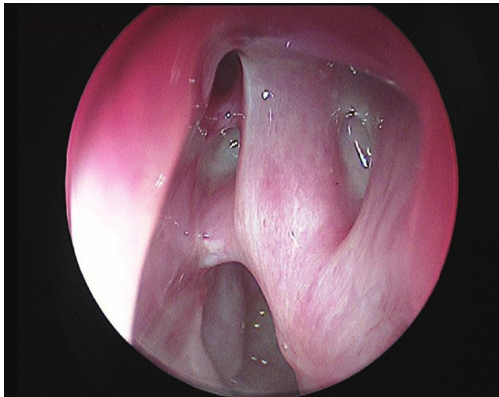
Figure 1: Computed tomography (CT scan) of the orbits shows complete opacity of the left frontal sinus with anterior and inferior breach of the sinus.